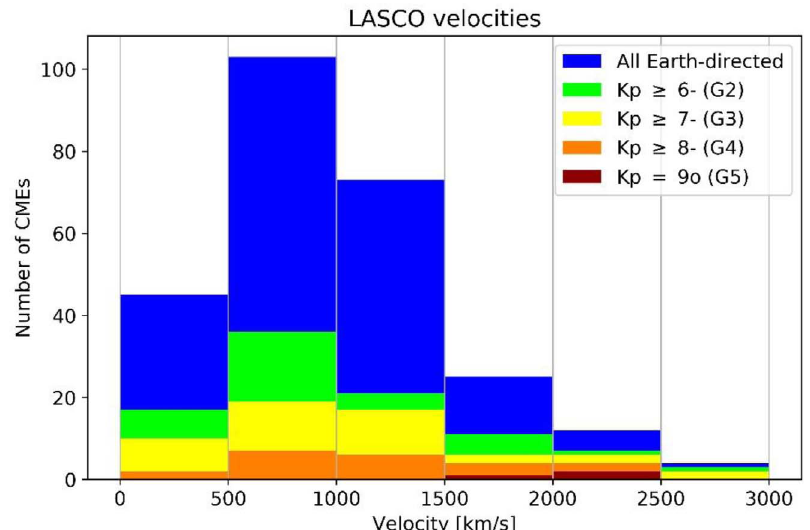
Fig. 3. The total number (261) of Earth-directed CME identi fi ed during the study (blue), and the numbers of these CME that resulted in geomagnetic storms (green to red), for Kp of 6 (cid:1) to 9o (G2 – G5), binned by LASCO solar wind speed.